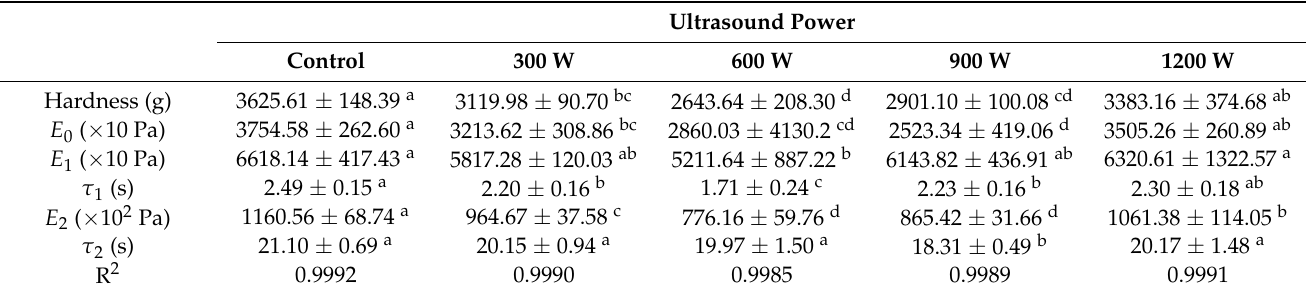
Table 1. Effects of different ultrasound power on stress relaxation parameters of WB. Ultrasound